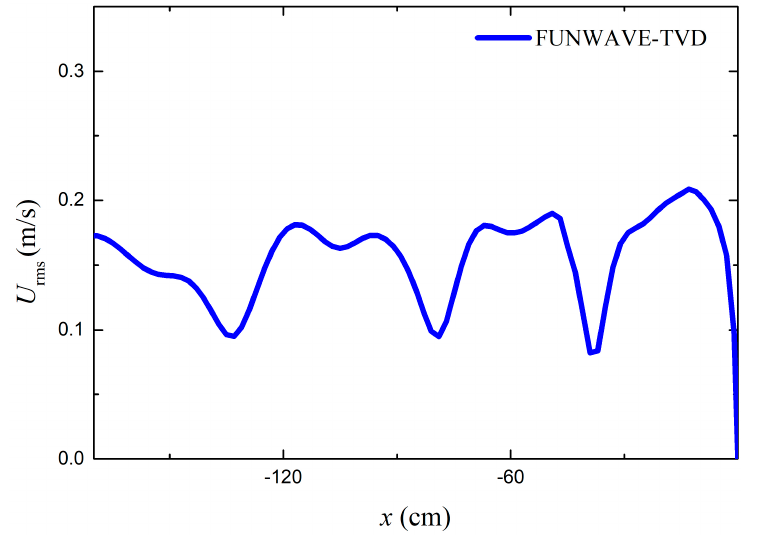
Figure 7. Predicted spatial distribution of root mean square of depth-averaged horizontal velocity near the seawall.